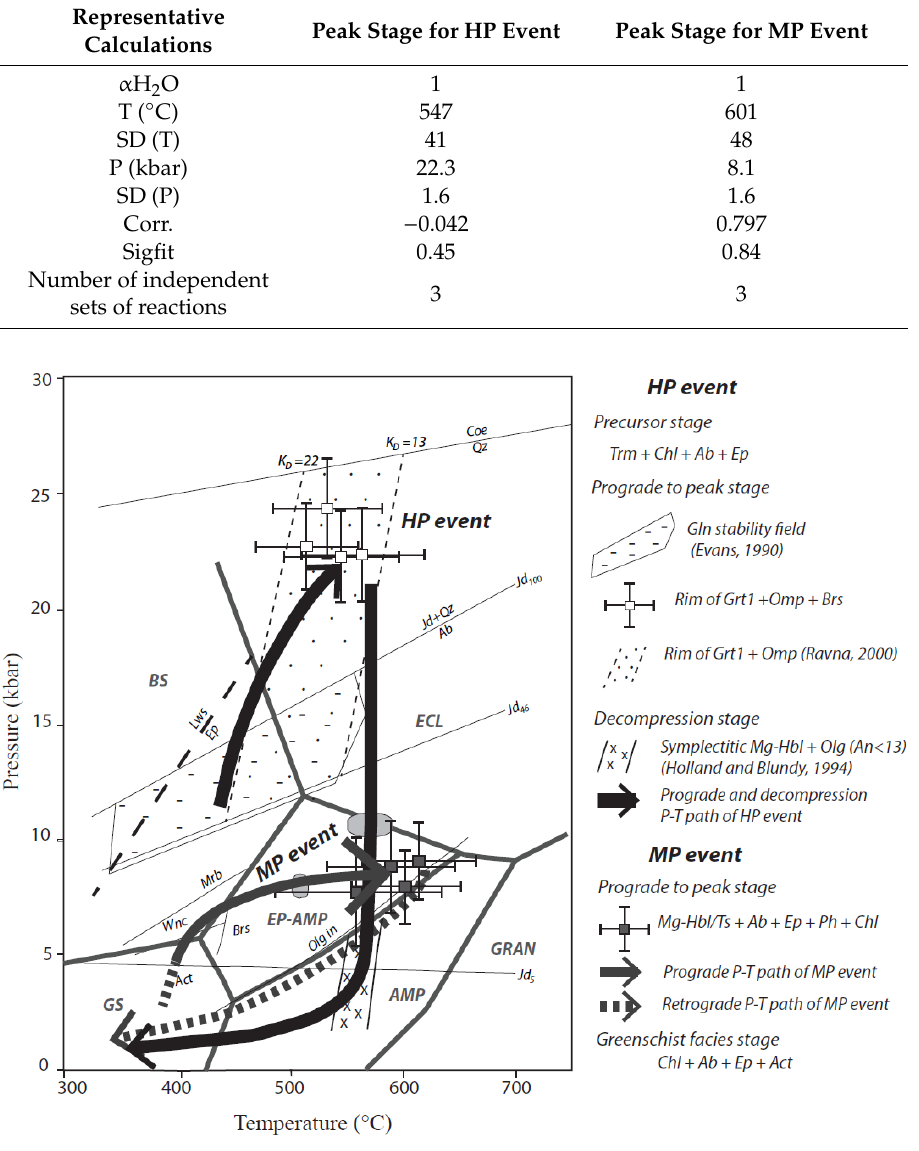
Figure 11. Estimated P-T conditions for eclogites and the amphibolitized eclogite of Alag Khadny metamorphic complex. ECL, eclogite facies; BS, blueschist facies; EA-AMP, epidote-amphibolite facies; AMP, amphibolite facies; GS, greenschist facies; GRAN, granulite facies. Dotted field of P-T conditions is represented by the K D [(Fe 2 + / Mg) Grt / (Fe 2 + / Mg) Cpx ] values of garnet-clinopyroxene pairs and maximum Jd content in omphacite without coesite estimated by thermobarometer. Thin lines show the stability fields of actinolite (Act), winchite (Wnc), magnesioribeckite (Mrb), and barroisite (Brs) and the thick dashed line is the boundary of lawsonite–blueschist and epidote–blueschist [37]. Ellipsoid gray colored polygon is P-T conditions of prograde and peak metamorphic stage of garnet-chloritoid schist [28]. Decompression Stage Table 5. Representative THERMOCALC calculations for peak stages for HP and MP events Peak Stage Peak Stage Representative for HP for MP Calculations Event